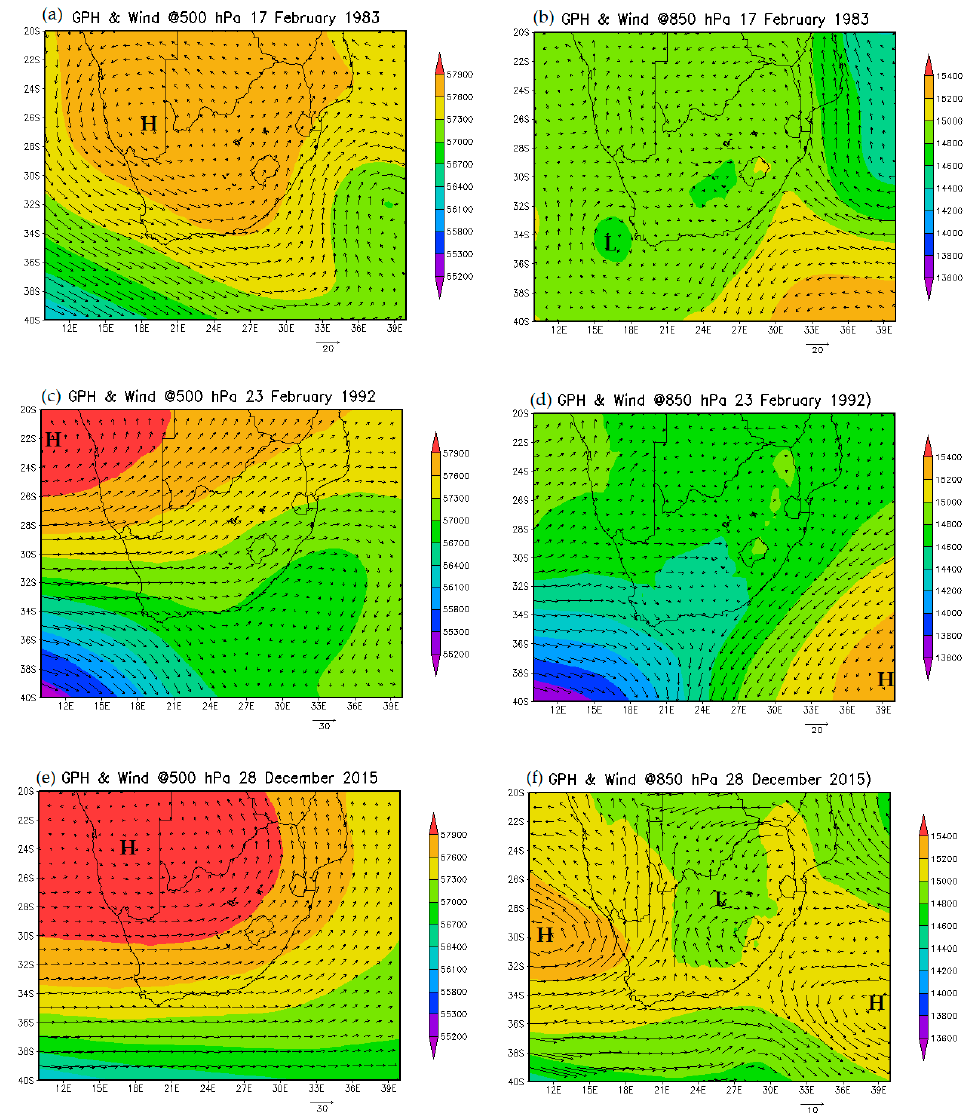
Figure 10. Geopotential height (GPH) x 10m and vector winds (m/s) at 500 hPa for the ( a ) 17–27 February 1983 HW, ( b ) 23 February 1991 to 2 March 1992 HW, and ( c ) 28 December 2015–9 January 2016 HW; and at 850 hPa for the ( d ) 17–27 February 1983 HW, ( e ) 1991 to 2 March 1992 HW, and ( f ) 28 December 2015–9 January 2016 HW. The arrows represent wind direction and